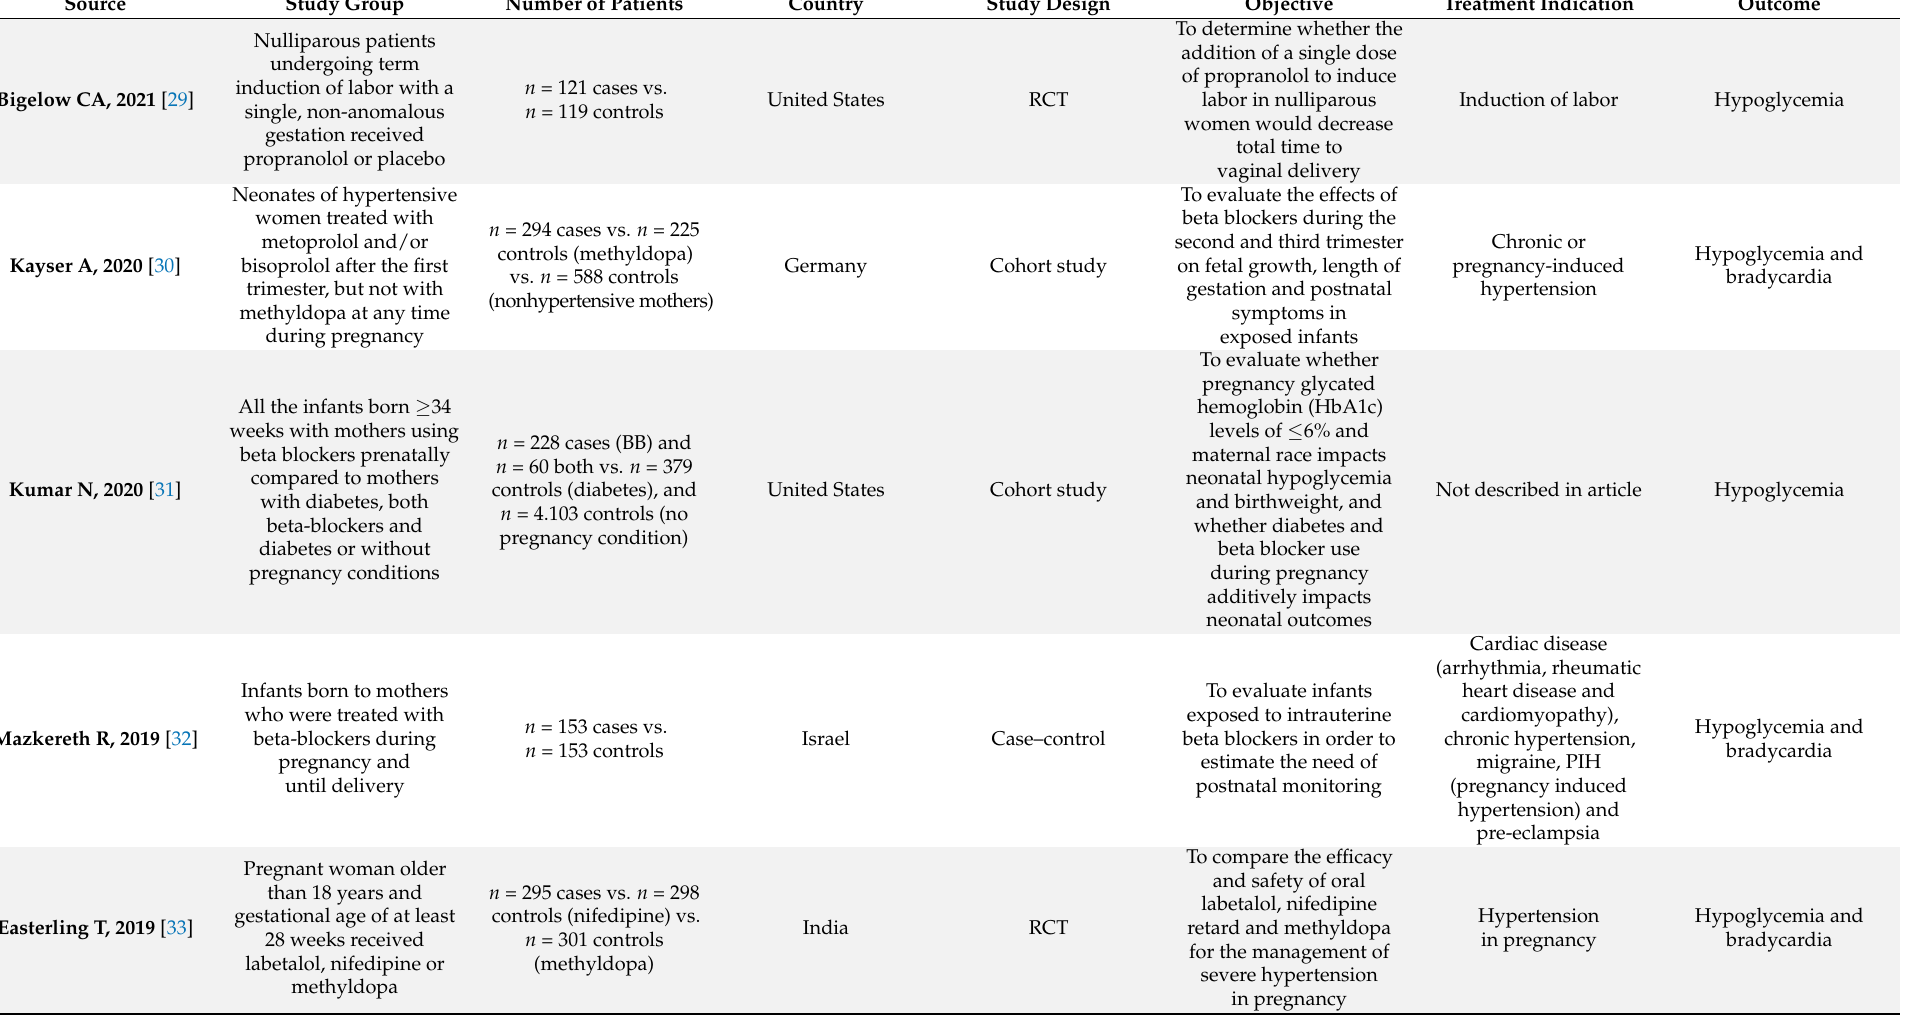
Table 2. Overview of 40 included